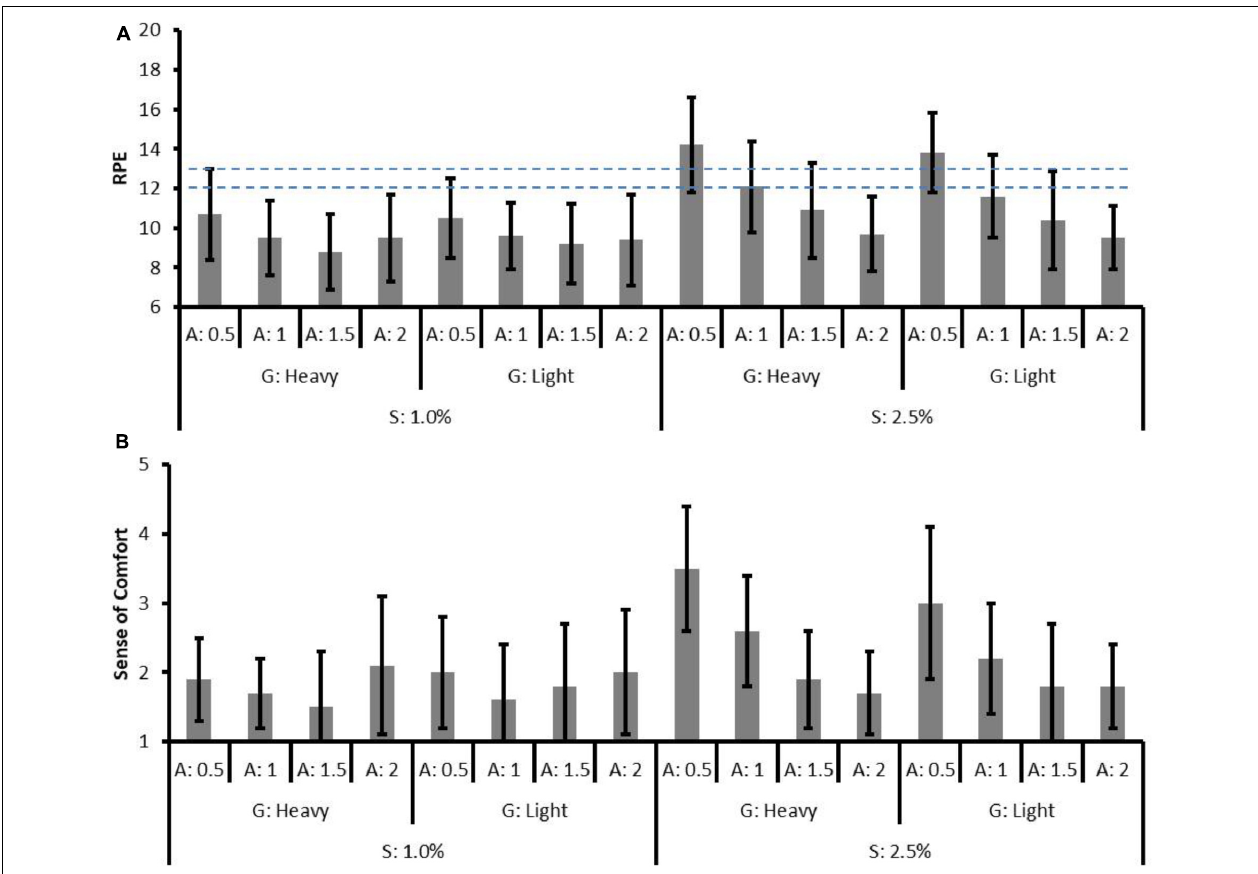
FIGURE 5 | The mean and standard deviation of (A) rate of perceived exertion (RPE) and (B) sense of comfort (SC) in all conditions. The horizontal dashed lines represent the upper and lower bound of moderate level defined by